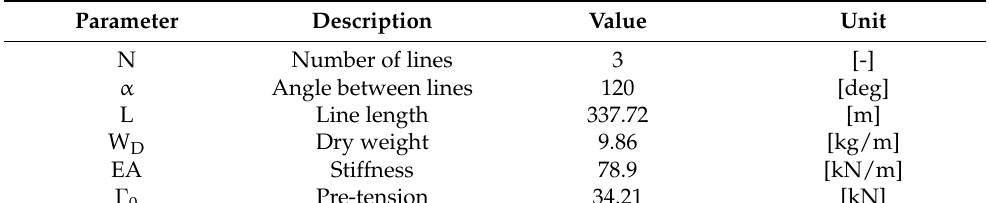
Table 2. Mooring parameters.